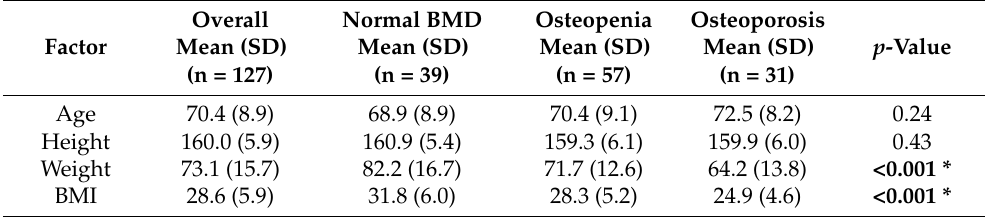
Table 1. Means, standard deviations, and one-way ANOVA results for the demographic data of the normal BMD, osteopenia, and osteoporosis groups.